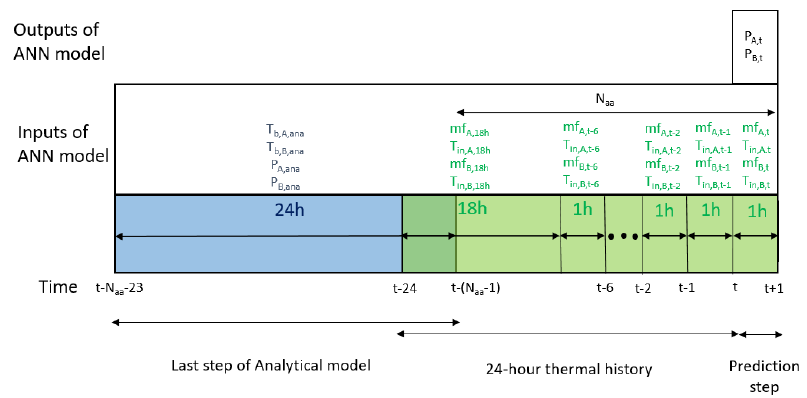
Figure 5. Inputs and outputs of the ANN model represented on a timeline.